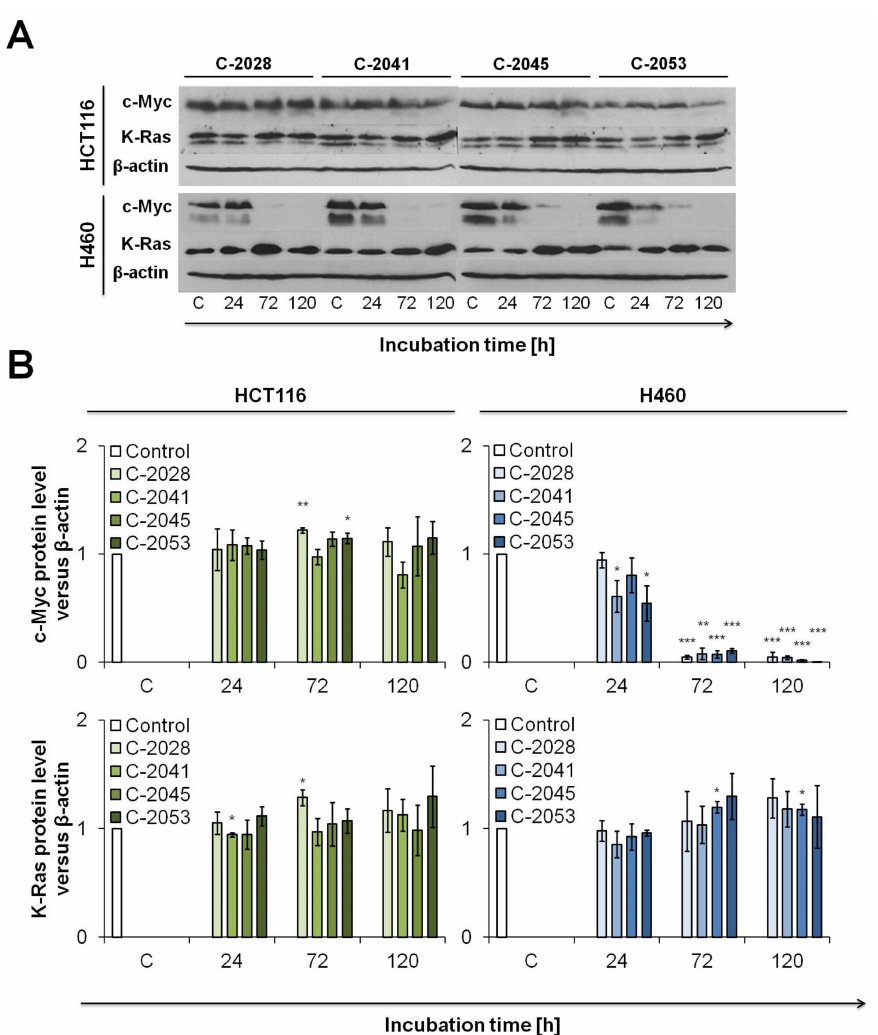
Figure 3. Western blot analysis of c-Myc and K-Ras protein levels in HCT116 and H460 cells. Cells were incubated with IC 90 doses of UAs for the times indicated. Whole cell extracts were prepared, 20 µ g of proteins/lane were separated by polyacrylamide gel electrophoresis and semi-dry transferred on a membrane. Protein levels were detected after immunostaining the membrane with appropriate antibodies and ECL developing. ( A ) Representative Western blot analysis of c-Myc and K-Ras in HCT116 and H460 cells and ( B ) their relative densitometry quantification performed using ImageJ Software. Significantly different from the control at: * p < 0.05; ** p < 0.01; *** p < 0.001; ( n ≥